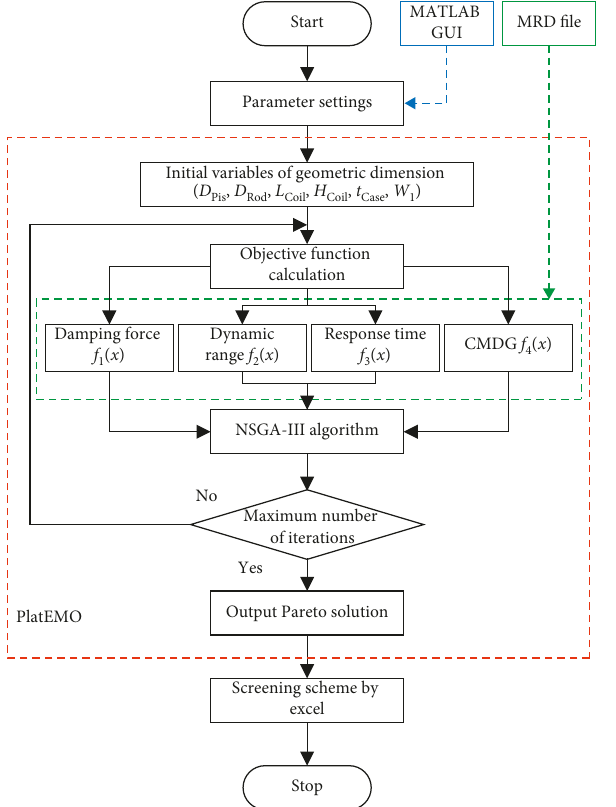
Figure 8: Working flow of optimal design.